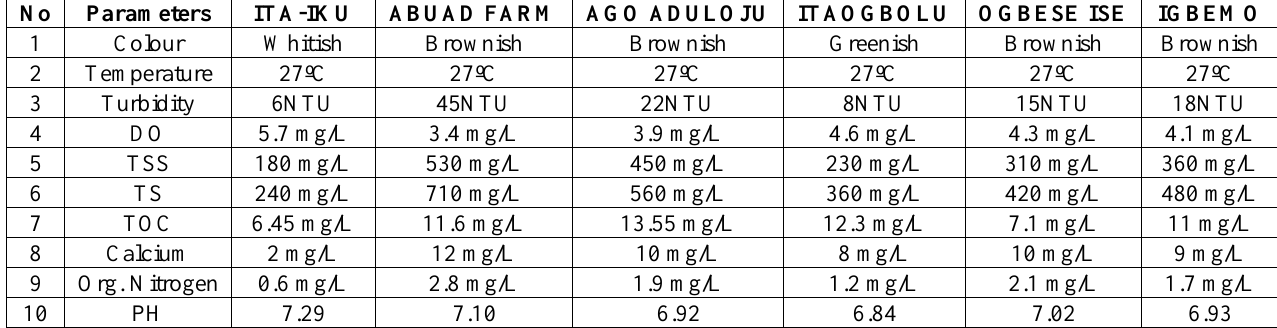
Table 2: Quality Parameters of selected locations along the River